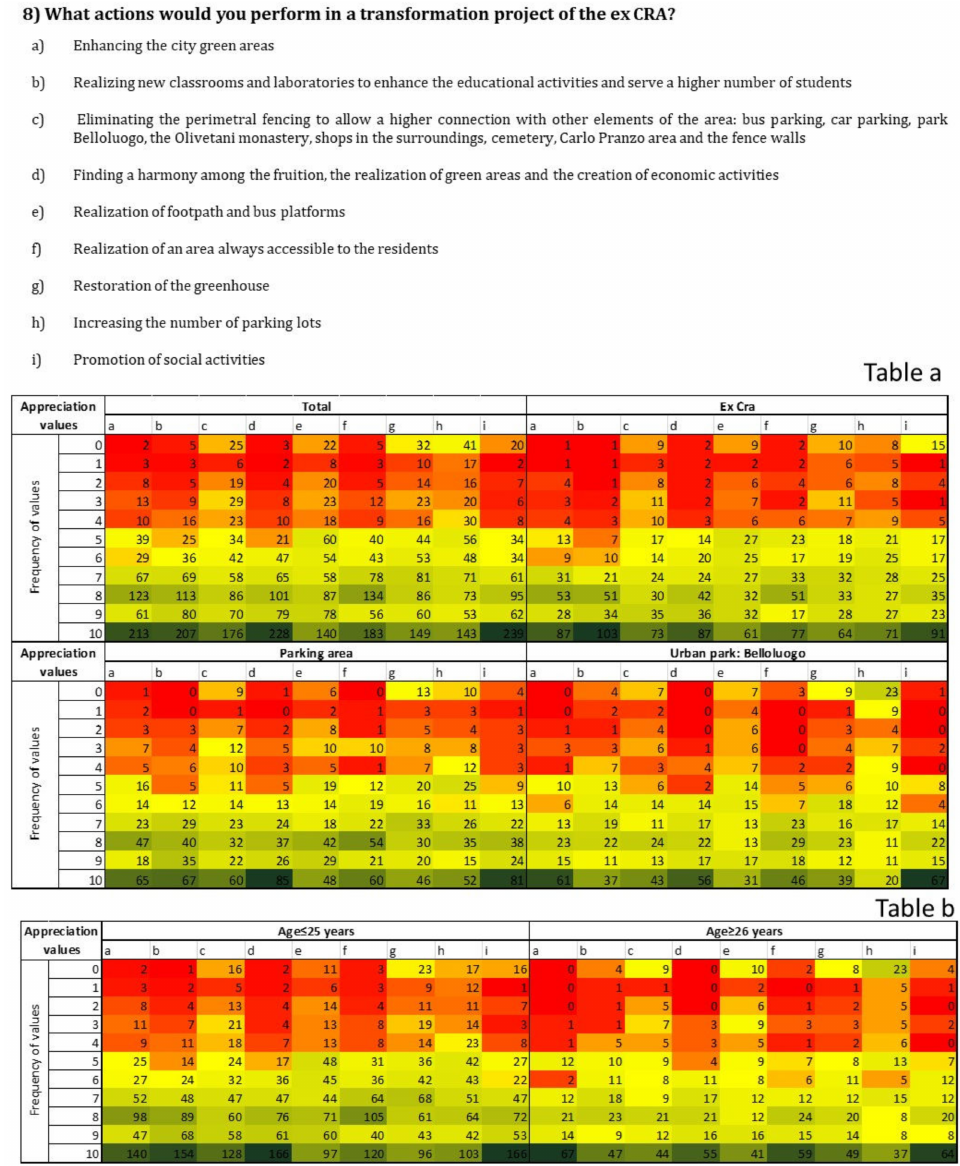
Figure 9. Heat map for the analysis of possible planning actions considering the di ff erent survey areas. The colors from red to green represent a gradient of preference from low preference to high preference in relation to the number reported in the cells of the table. ( a ) The answers were analyzed, considering both the single survey areas and the whole. ( b ) The answers were analyzed considering two age groups: under 25 years and over 25